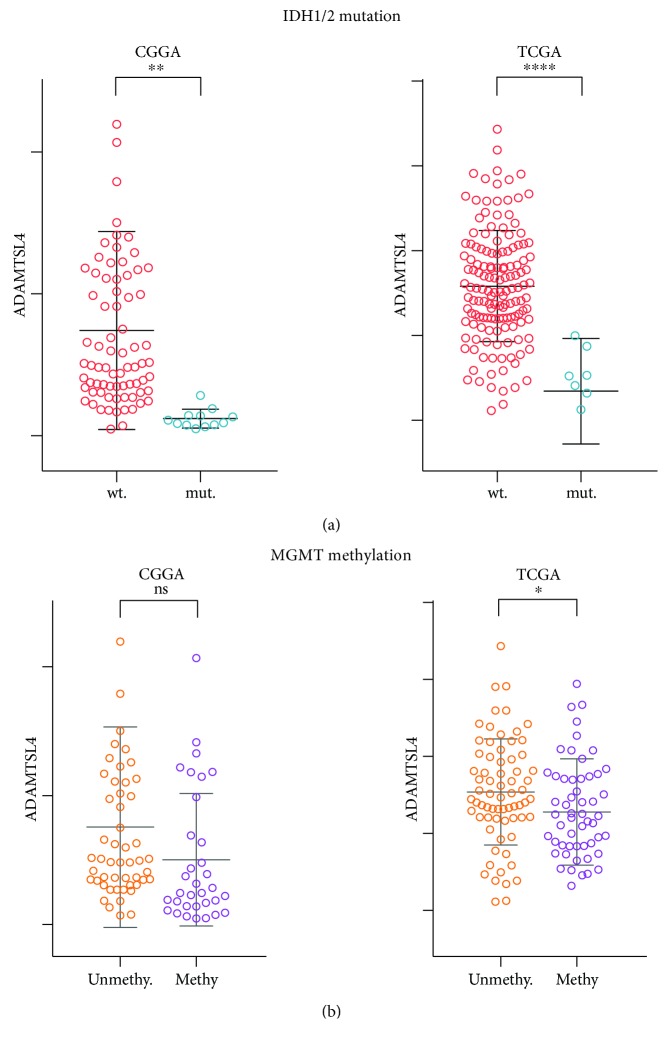
ADAMTSL4 was correlated with existing biomarkers in pGBM (WHO grade IV). ADAMTSL4 was significantly increased in IDH1/2 wild-type pGBMs both in the CGGA and TCGA database (a). ADAMTSL4 was significantly increased in MGMT unmethylated group in the TCGA database, but no significance was tested in the CGGA database (p = 0.1033) (b). ns, ∗, ∗∗, and ∗∗∗∗ indicate p > 0.05, p < 0.05, p < 0.01, and p < 0.0001, respectively.